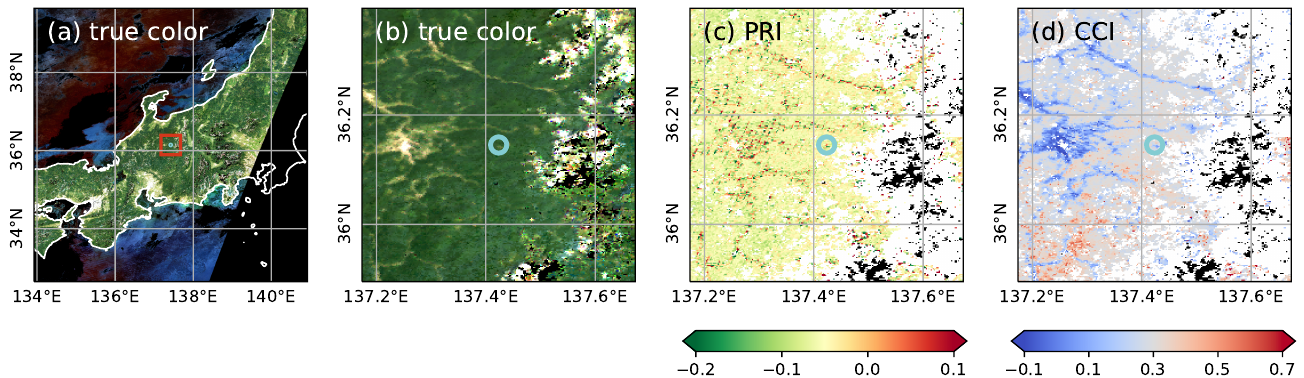
Figure 14. The spatial distribution of PRI satellite and CCI satellite on 2 August 2019 (DOY = 214) around TKY. The cyan circles in each figure indicate the location of TKY. The red rectangle in ( a ) represents the range of ( b – d ). ( a ) shows the true color image of GCOM-C/SGLI. ( b ) shows the true color image, ( c ) shows PRI satellite , and ( d ) shows CCI satellite . ( a , b ) are not screened with the QA flag and ( c , d ) are screened with the QA flag.